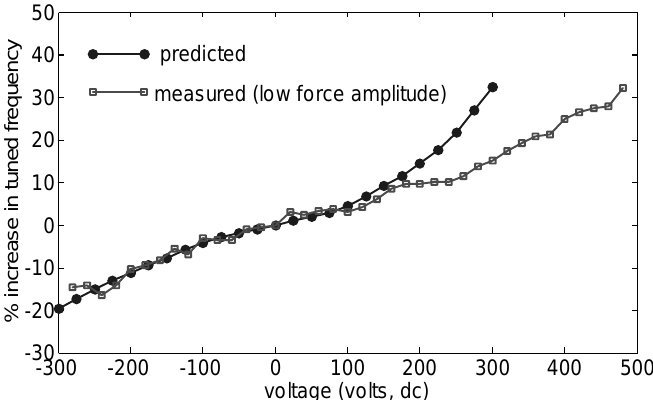
Fig. 6. Tuning characteristic for the prototype ATVA shown in Fig.